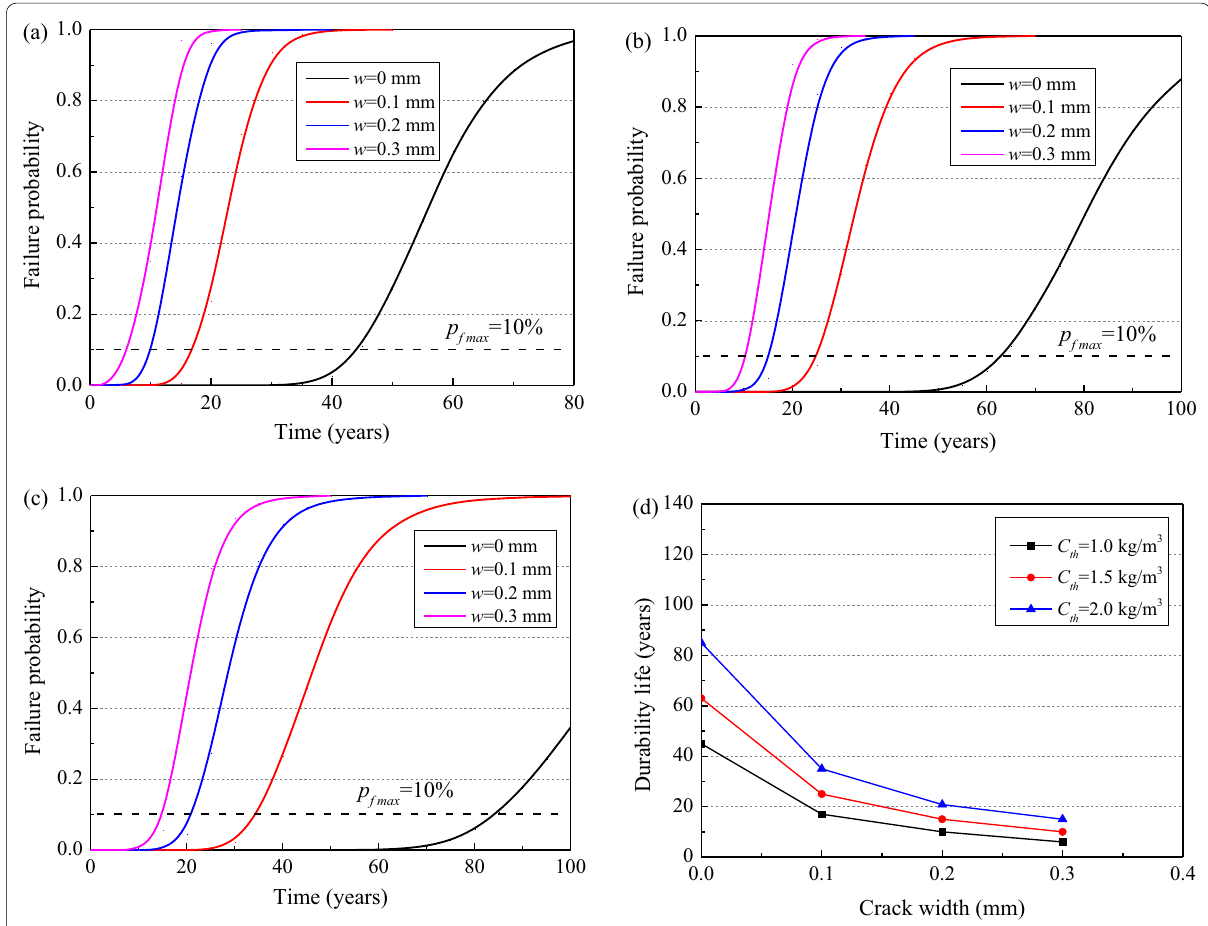
Fig. 11 Effect of chloride threshold value on failure probability: a C th